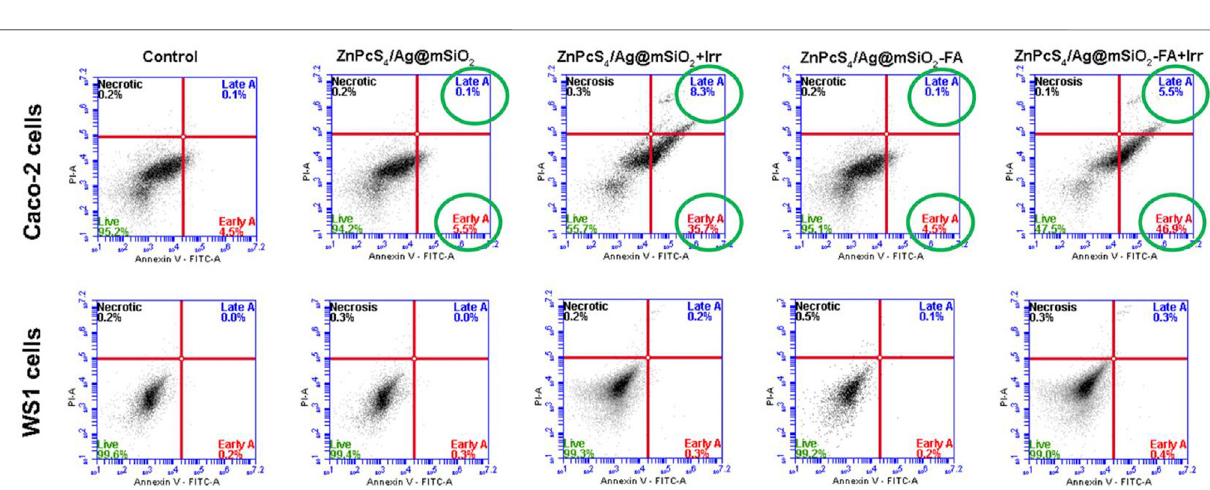
Frontiers in Nanotechnology |